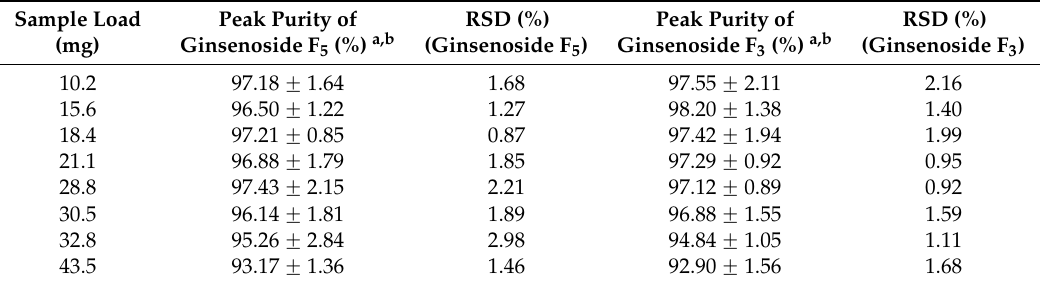
Table 2. The influence of the sample load on the separation effect of CEFBPG.